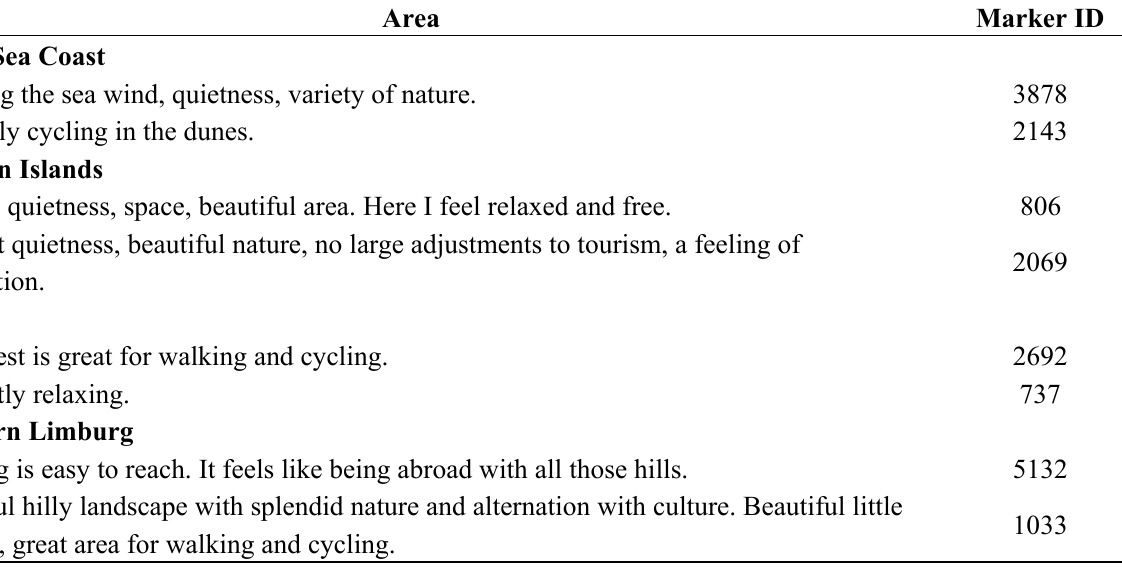
Table 3. Examples of quotes from the Hotspotmonitor data describing the attractiveness of the